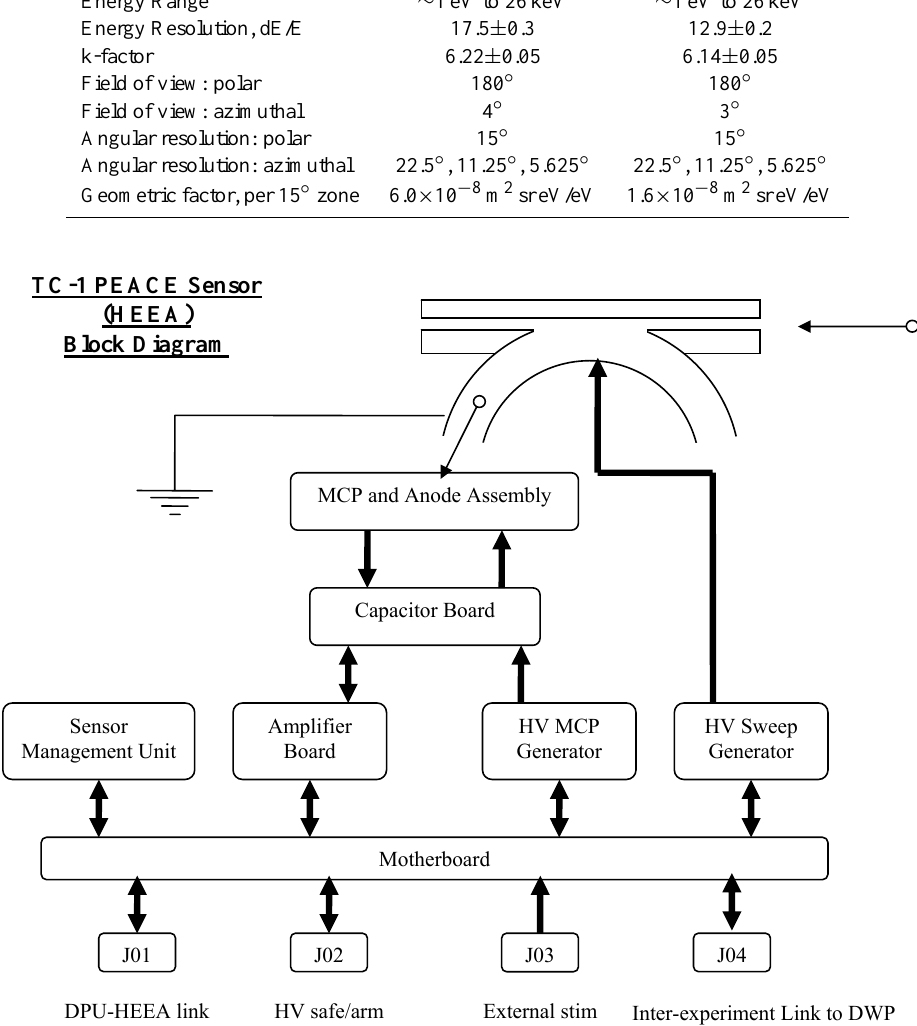
Fig. 3. Block Diagram of TC-1 PEACE Sensor (a HEEA). The small circles with attached thin arrows represent electrons approaching and travelling through the electrostatic analyser to be detected at the MCP and Anode Assembly. The LEEA sensor is identical except that J04 is absent.